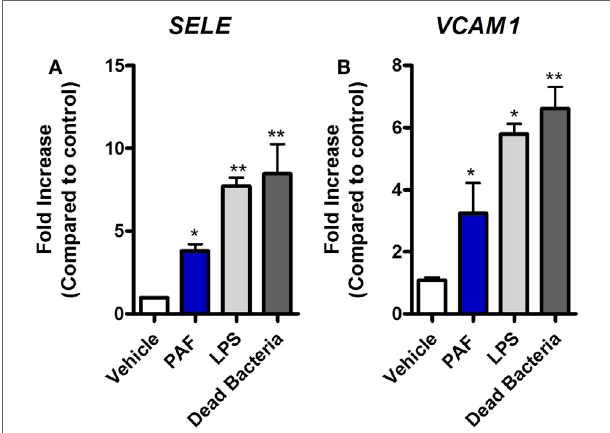
FigUre 10 | Exogenous platelet-activating factor receptor (PAF) directly promotes upregulation of adhesion molecules gene expression in chicken endothelial cells. (a) E-selectin/ SELE and (b) VCAM-1/ VCAM1 gene expression in chicken aortic endothelial cells (chAEC) following treatment with PAF (10 µM), lipopolysaccharide (LPS) (10 ng/ml), or dead bacteria (10 multiplicity of infection) for 6 h. Quantitative real-time PCR data are expressed as relative normalized expression (as compared to vehicle control group). Values are mean ± SEM. * P < 0.05 and ** P < 0.01 when compared to negative (vehicle) control